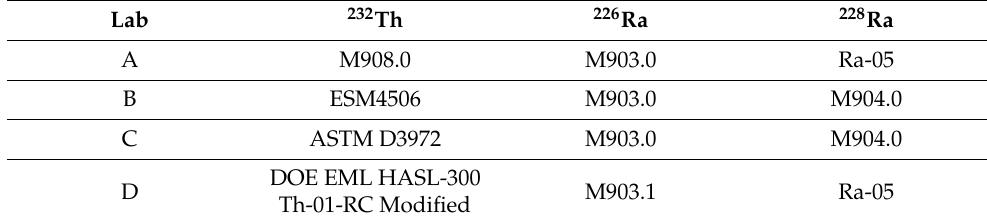
Table 1. List of laboratories and methods used in the ILC.